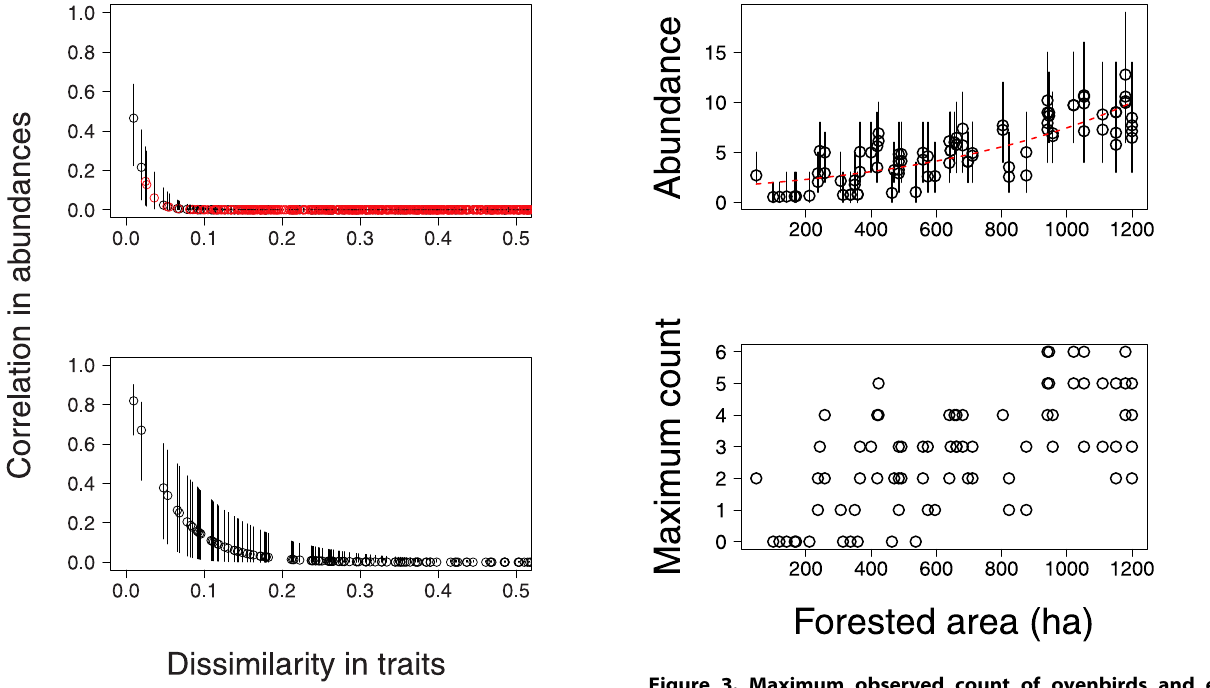
Figure 2. Estimated correlations in abundance between species (posterior medians and 95% credible intervals) as a function of dissimilarity in their morphological traits. Black indicates species of same foraging guild; red indicates species of different foraging guilds. Upper panel corresponds to estimates obtained by assuming correlated abundances among all species; lower panel correponds to estimates obtained by assuming correlated abundances among species of same foraging guild. Estimated correlations are equal to zero for species with trait dissimilarities greater than 0.5.